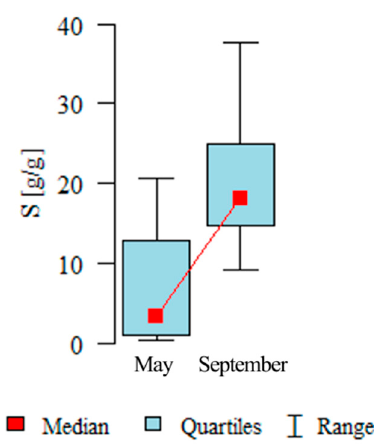
Figure 3. Images of the common oak leaf surface obtained by the scanning electron microscope (SEM):